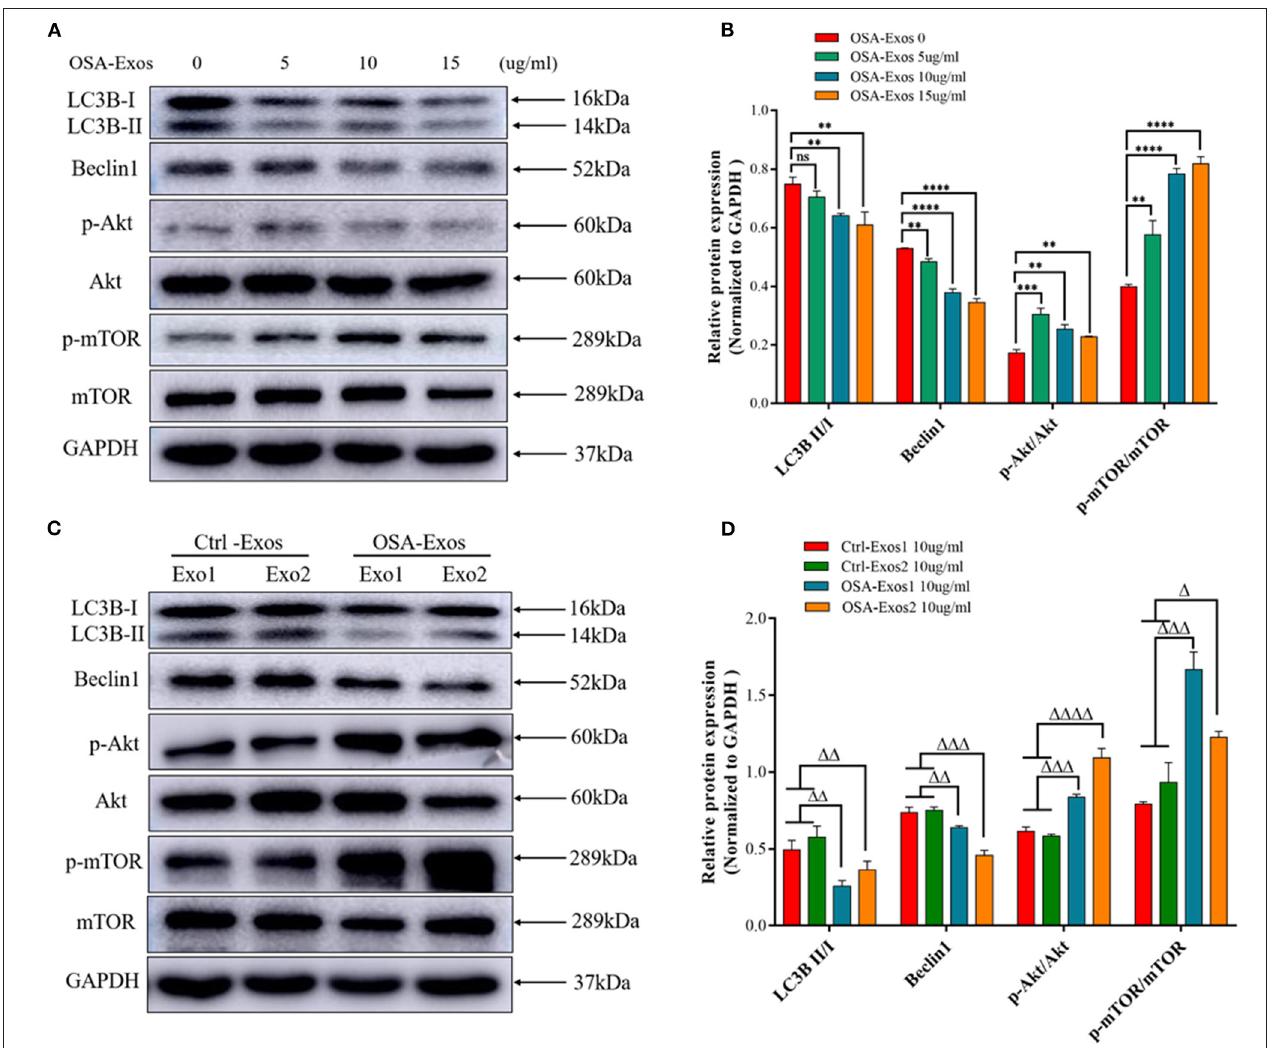
FIGURE 3 | OSA-Exos inhibited autophagy via the Akt/mTOR signaling pathway in H 9 C 2 cells. (A) LC3B II/I expression decreased in H 9 C 2 cells treated with 10 and 15 µ g/ml exosomes from one OSA patient compared with the 0 (control) and 5 µ g/ml. Beclin1 protein expression decreased, p-Akt/Akt and p-mTOR/mTOR expression increased in H 9 C 2 cells treated with 5, 10 and 15 µ g/ml exosomes compared with the control (0 µ g/ml). (B) Densitometric analyses of the Western blot presented in A. (C) LC3B II/I and beclin1 protein expression decreased, p-Akt/Akt and p-mTOR/mTOR expression increased in H 9 C 2 cells treated with 10 µ g/ml OSA-Exos compared with the control as determined by Western blot analysis. (D) Densitometric analyses of the Western blot presented in C. GAPDH served as the internal control. The bars indicate the mean ± SD of three separate experiments. ** p < 0.01, *** p < 0.001, **** p < 0.0001 vs. OSA-Exos 0 group. 1 p < 0.05, 11 p < 0.01, 111 p < 0.001, 1111 p < 0.0001 vs. Ctrl-Exos groups. ns, no